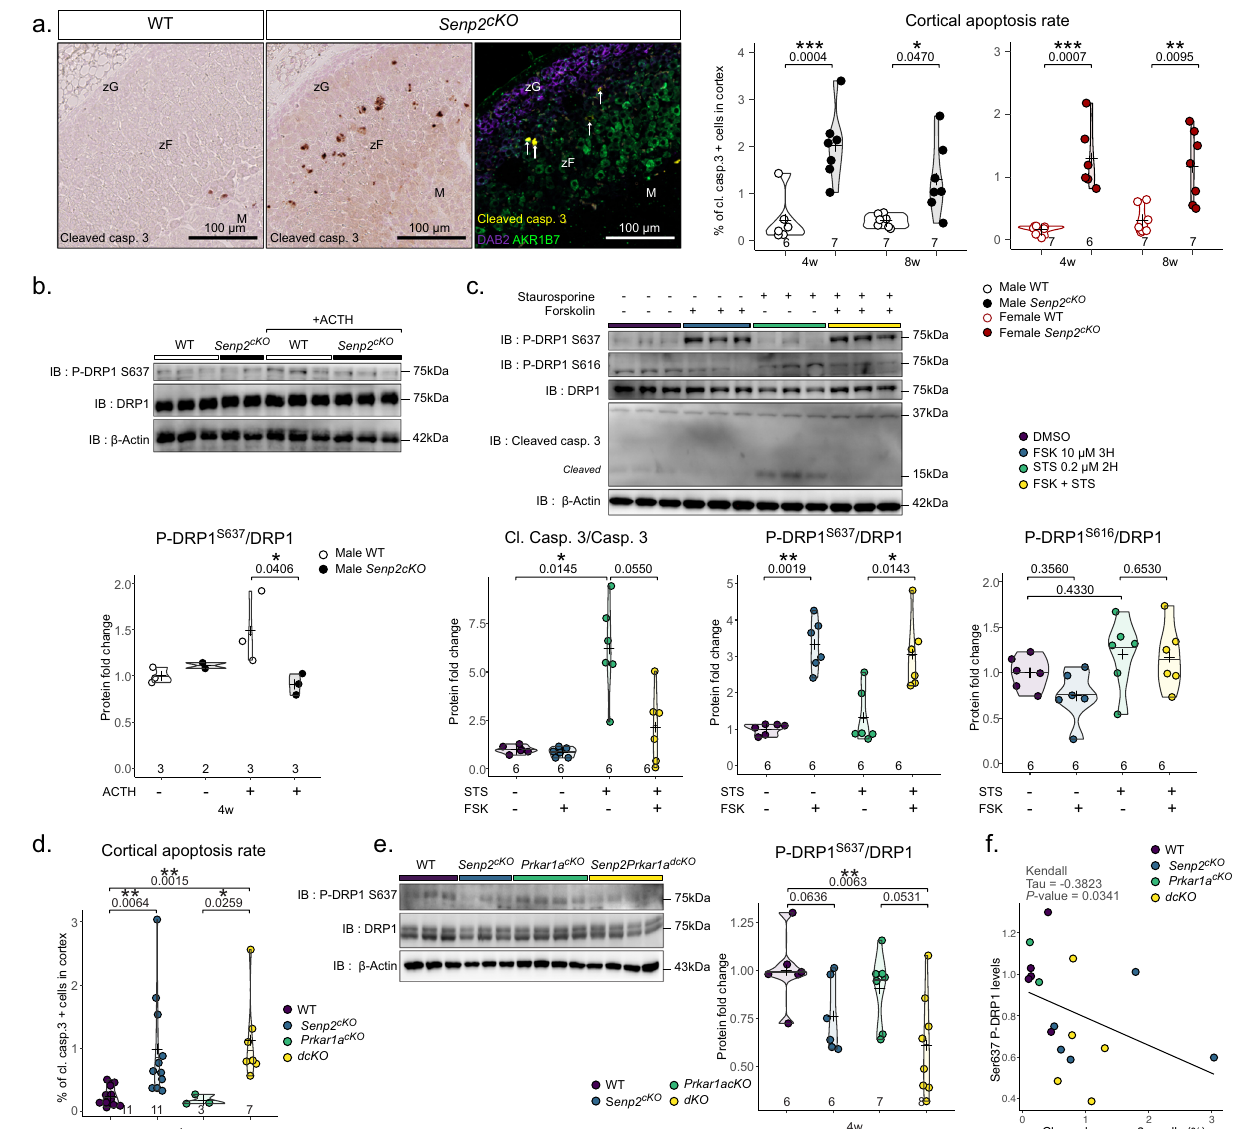
Fig. 6 | Senp2 loss triggers apoptosis at the zG-zF boundary. a Representative image of cleaved caspase-3 immunostaining and immuno fl uorescence labelling of cleaved caspase-3 (yellow), zG marker Disabled2/DAB2 (purple) and zF marker AKR1B7 (green). Quanti fi cation of apoptosis in WT and cKO through measurement of the percentage of cells positive for cleaved caspase-3 at 4 and 8 weeks of age. P values were determined by a two-sided t test for normally distributed condition